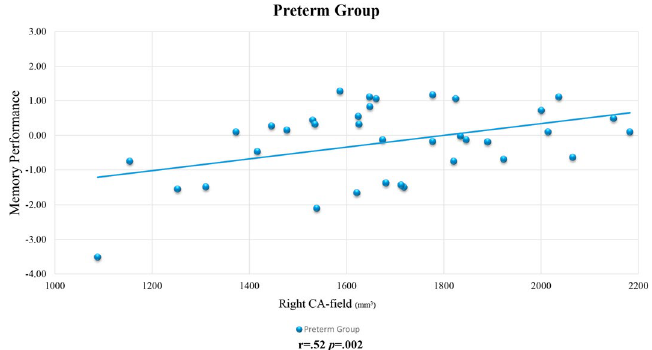
Figure 1. Correlation between the right CA-field and memory performance in preterm-born children. Note: mm 3 : cubic millimeter. Details of Pearson correlation coefficient (r) and p -corrected value are provided. Significant results were obtained between the right CA-field volume and memory performance after Bonferroni correction for multiple comparisons was applied ( p = .006). Unstandardized residuals were calculated and used for display purposes (adjusted according to age and